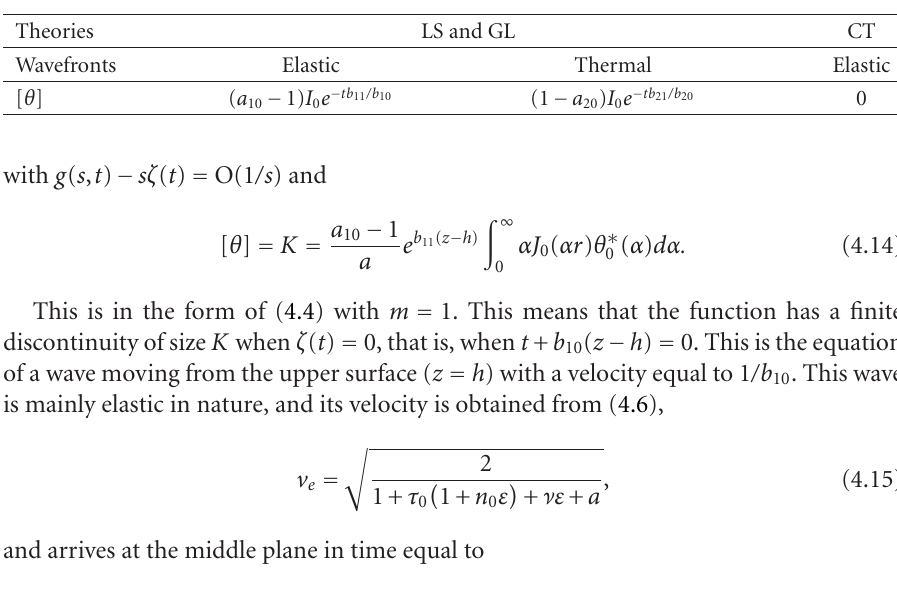
(cid:20) ∞ αJ 0 ( αr ) θ ∗ 0 ( α ) dα . 0